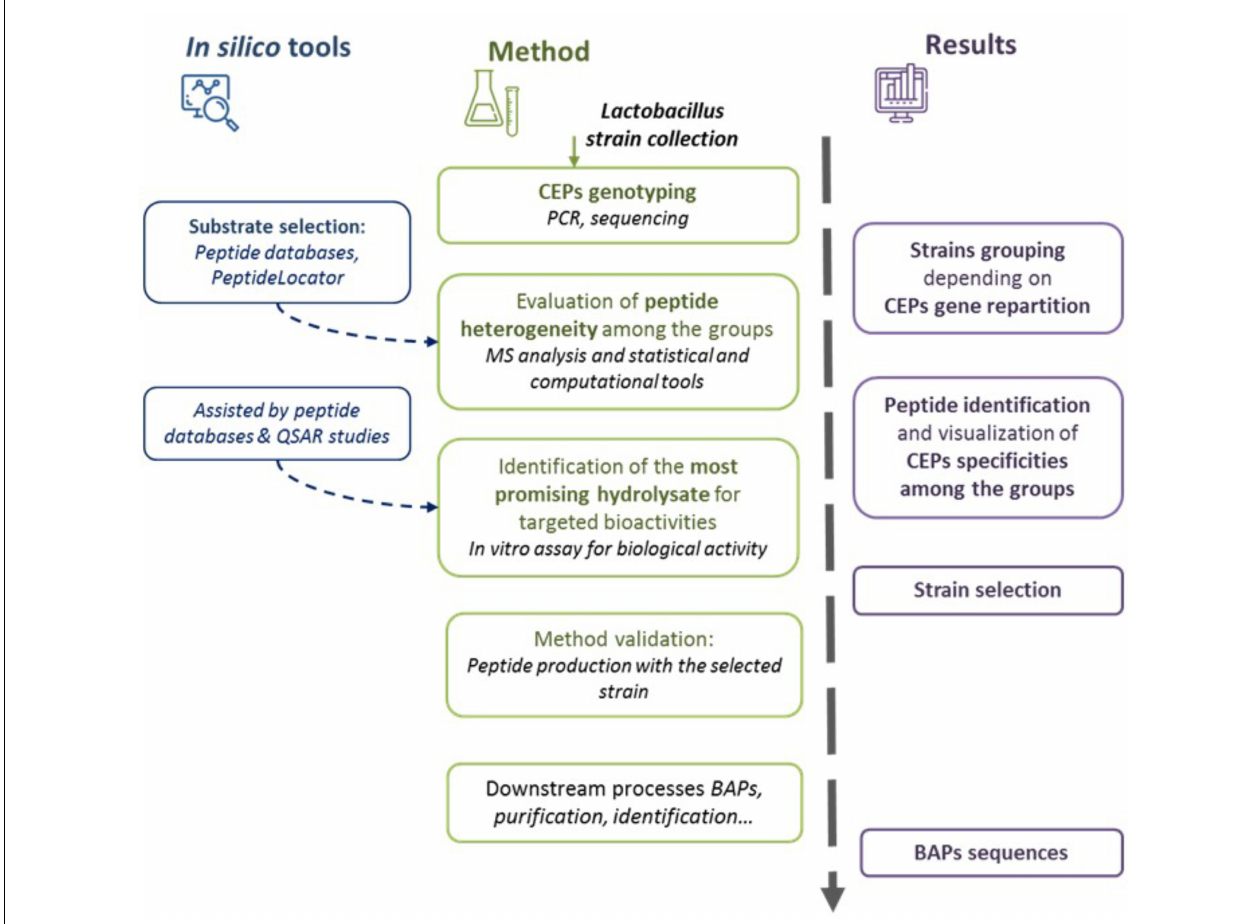
FIGURE 2 | Schematic representation of the proposed methodology of Lactobacillus strains selection to produce bioactive peptides (BAPs). Cell envelope proteinase (CEPs) genotyping is performed, followed by the evaluation of the heterogeneity of the produced peptides. The most promising hydrolysate is selected depending on the targeted application. Finally, the selected strains are tested for method validation. Different in silico tools could be used during the